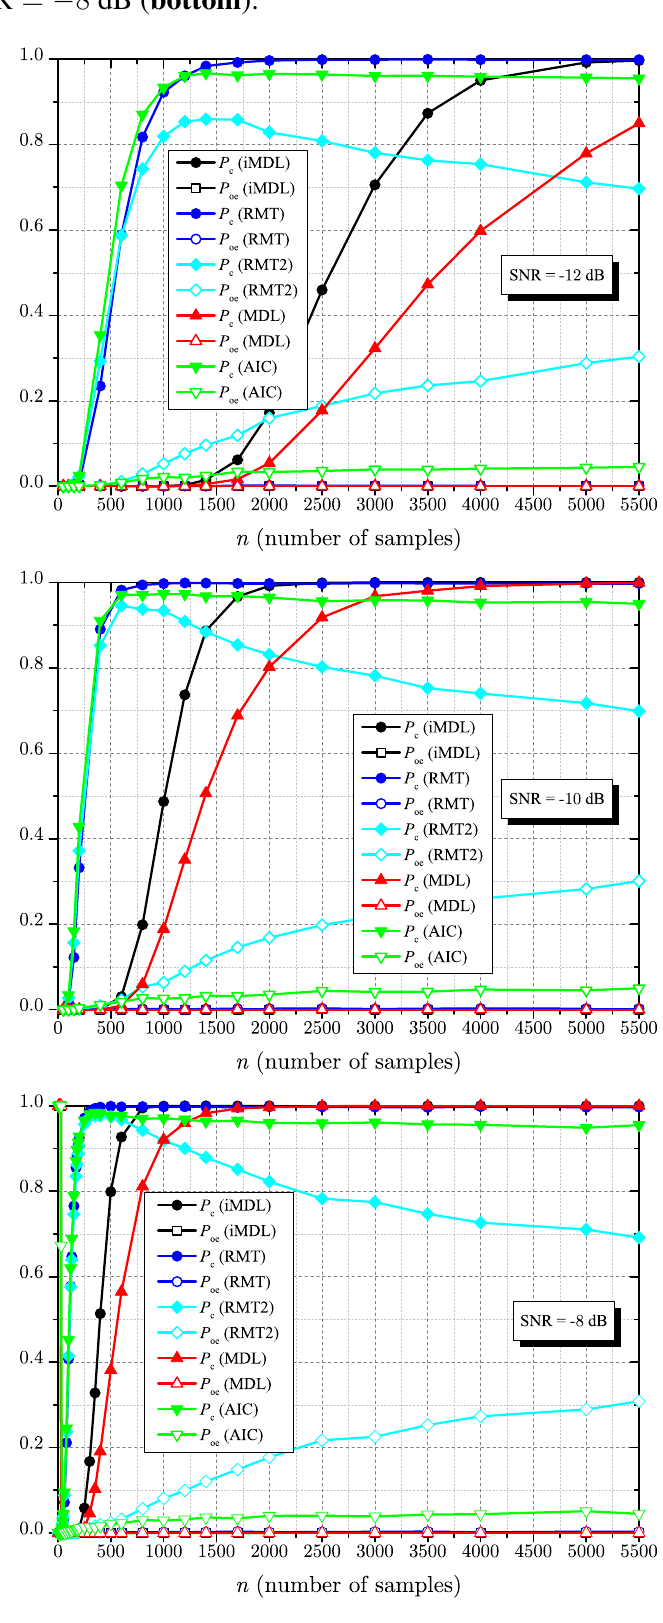
Figure 3. P and P against n for p = 3 , m = 30 , SNR = − 12 dB ( top ); SNR = − 10 dB c oe ( middle ) and SNR = − 8 dB ( bottom